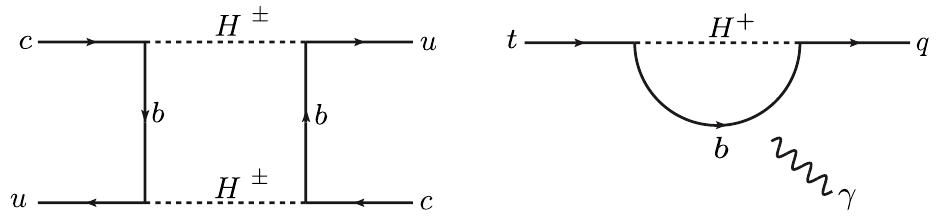
Figure 1 . Box diagram contributing to D – D mixing (left), and photon penguin inducing rare top decays t → qγ , q = u, c (right), where the photon is attached to any charged